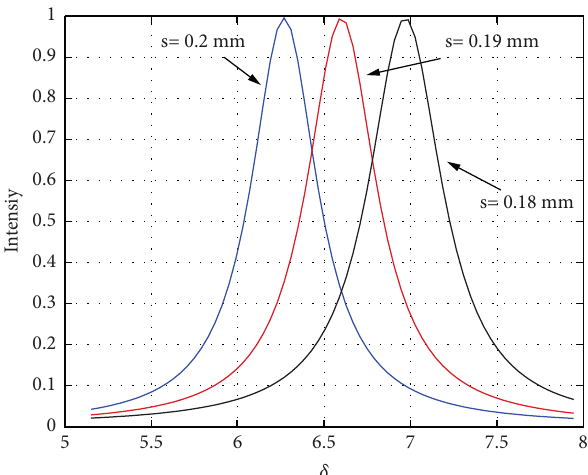
λ =632.8 nm Figure 3: Transmitted intensity of a line of the interference pattern as a function of δ for a F - P interferometer. Te parameter is the spacing s between the mirrors. Te interference line has a movement in the right direction when the spacing